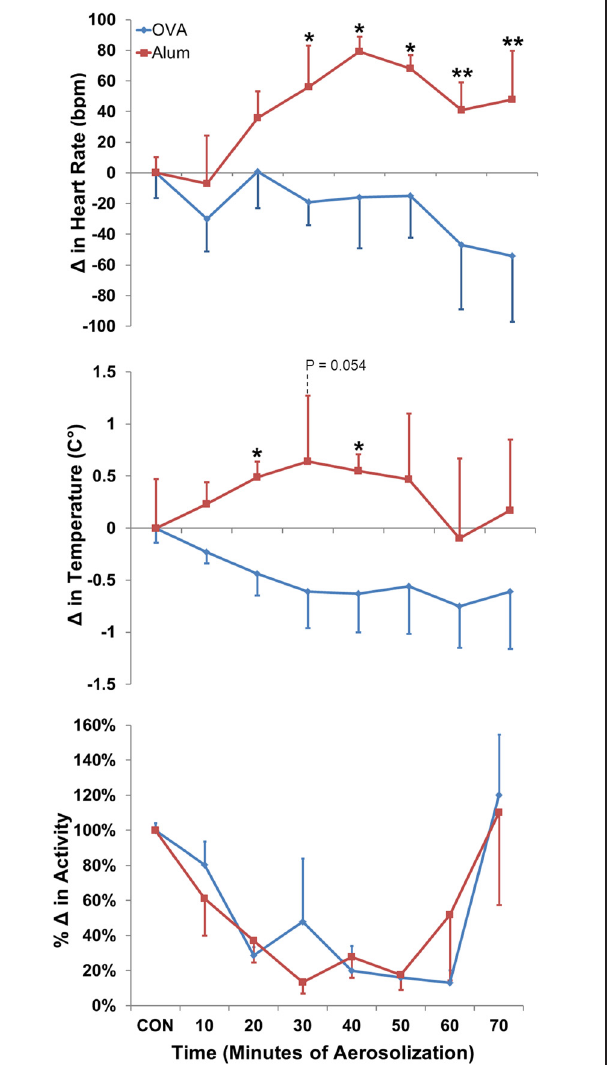
FIGURE 3 | Change in HR (top panel), T B (middle panel), and activity (bottom panel) during aerosol challenge. The baseline control values (CON) were calculated based on the means of HR, T B , and activity for the 40min directly preceding Ag challenge. OVA-sensitized mice displayed a decreased HR and T B profile compared with Alum control mice (both P ≤ 0 . 001 via Two-Way ANOVA, activity: NSD; Holm-Sidak post-hoc analyses: ∗ P < 0 . 05; ∗∗ P < 0 .